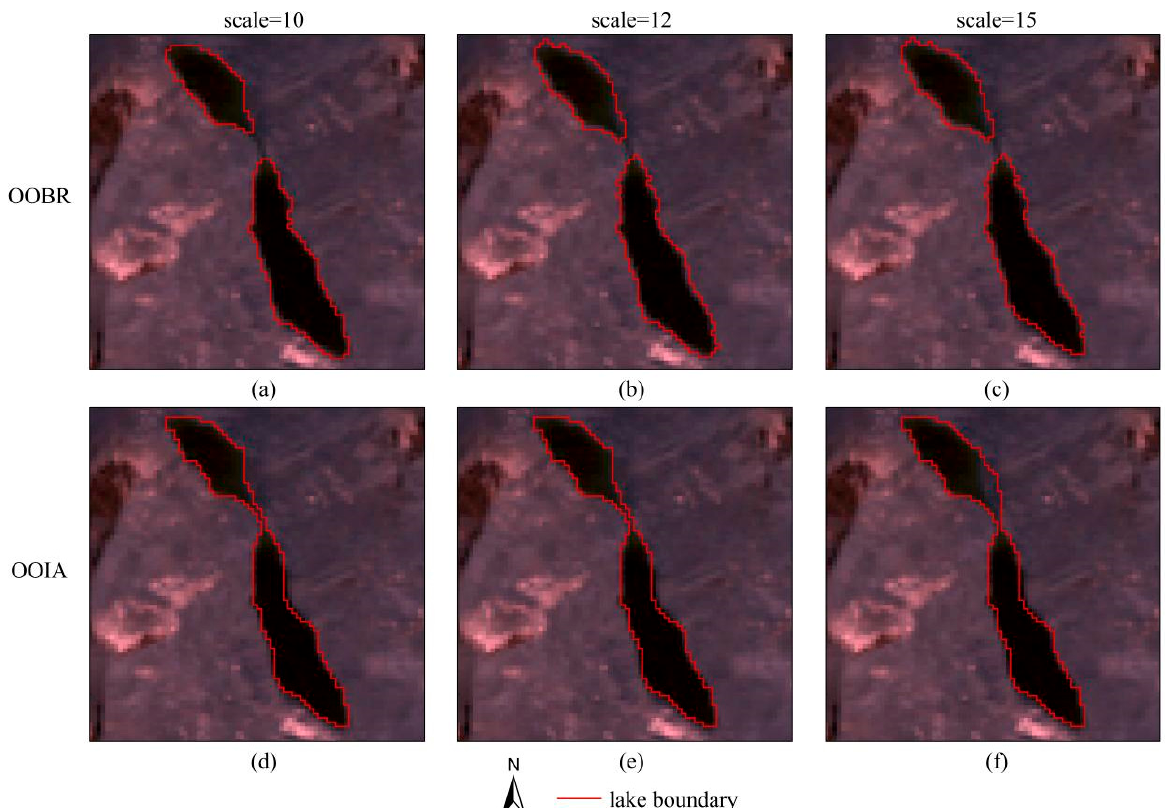
Figure 13. Results of the two methods with different segmentation scales image: ( a – c ) are the results using OOBR method with segmentation scale settings of 10, 12 and 15, respectively; ( d – f ) are the results using OOIA method with segmentation scale settings of 10, 12 and 15, respectively.